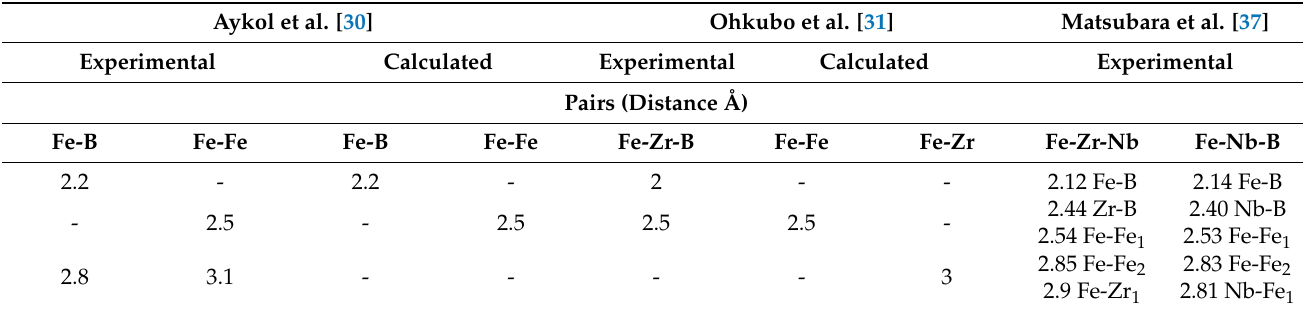
Table 2. Experimental and calculated profiles for other Fe-based MGs with the available data by other